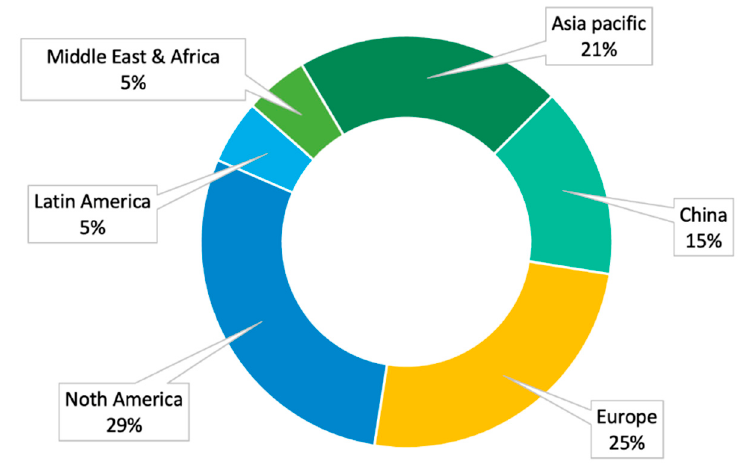
Figure 11. Fish-collagen market segmentation by Continent in 2019 Figure 11. Fish ‐ collagen market segmentation by Continent in 2019 [207].